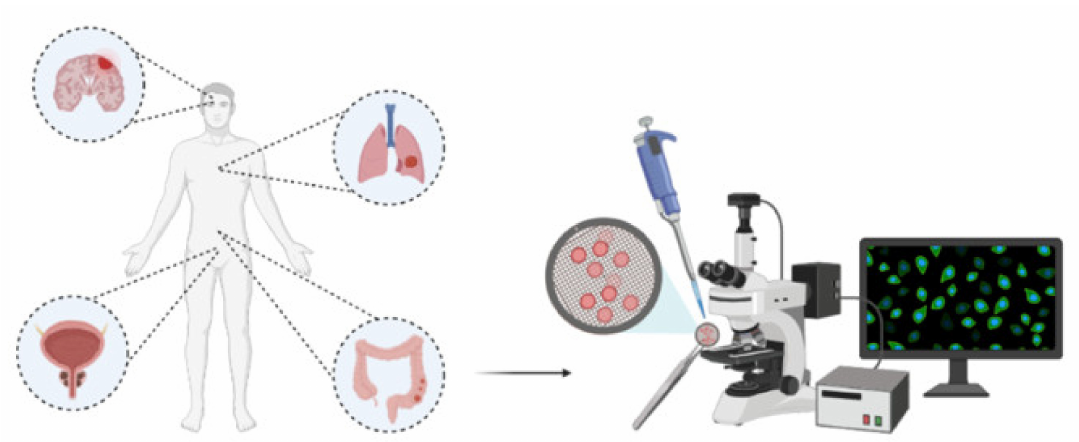
Figure 10. Confocal microscopy being used for the mapping of tissues experiencing tumor growth and for the monitoring of the path taken by the biomolecule inside the cell, which enables the detection of tumor